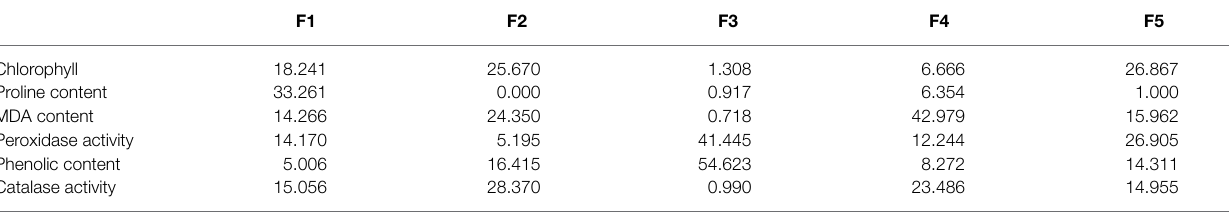
TABLE 3 | Contribution of biochemical variables (%) in principal components under drought